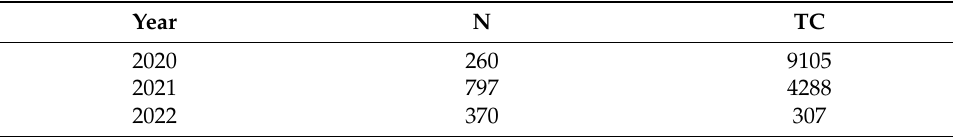
Table 2. Distribution of publications and citations.